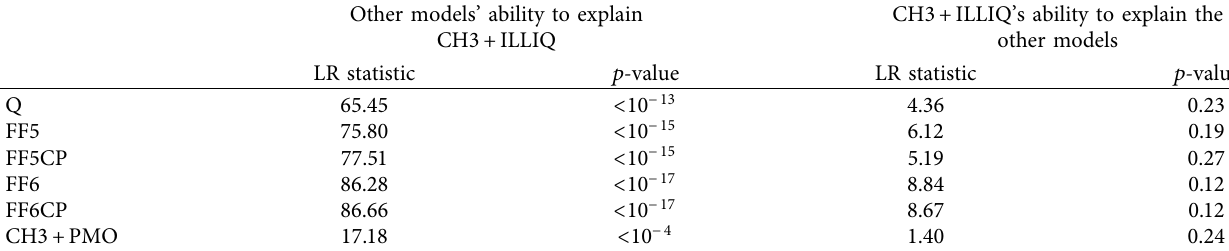
Table 6: Candidate models’ ability to explain the factors in each other.